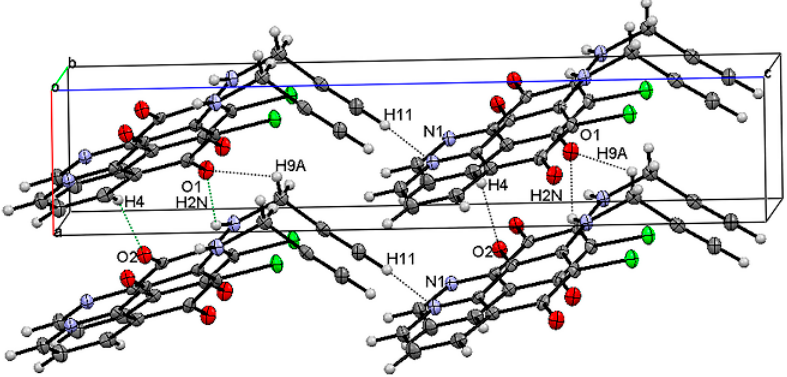
Figure 2. Crystal structure and hydrogen bonds for 6-chloro-7-propargylamine-5,8-quinolinedione 2a . Table 2. Parameters (Å, Degree) of the hydrogen bonds for compounds 2a and 3a .